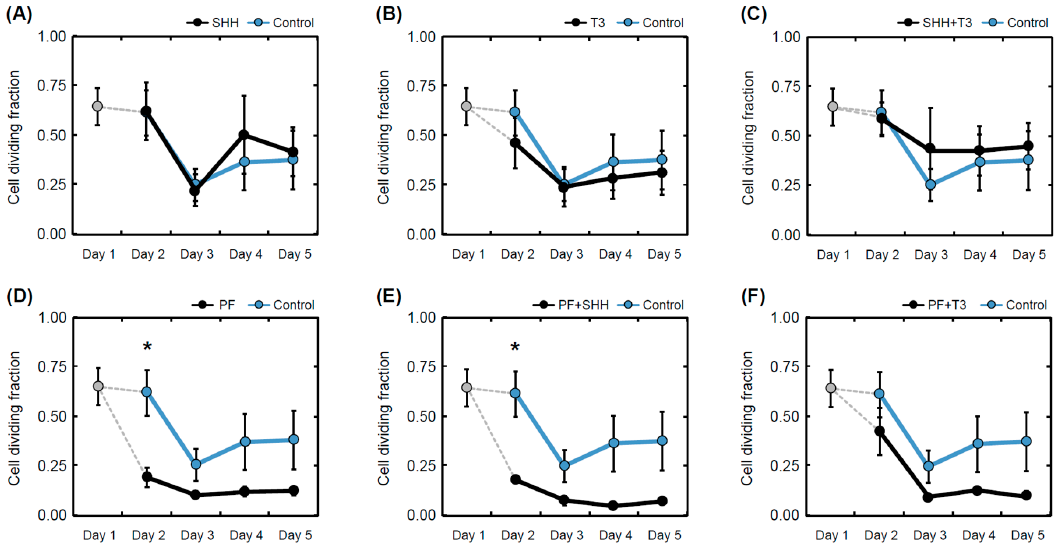
Figure 4. Mean proliferation rate. Proliferation rate determined as a fraction of dividing (BrdU-positive cell nuclei) cells over all detected cells in individual treatments ( A – F ) and controls on individual days of the di ff erentiation phase of the experiment (day 1 to day 5). The error bars represent ± SEM. Statistically significant di ff erence relative to control cells (between group): * p < 0.05. Statistical significance for within group comparisons (day 1 versus day 5) are provided in the text.